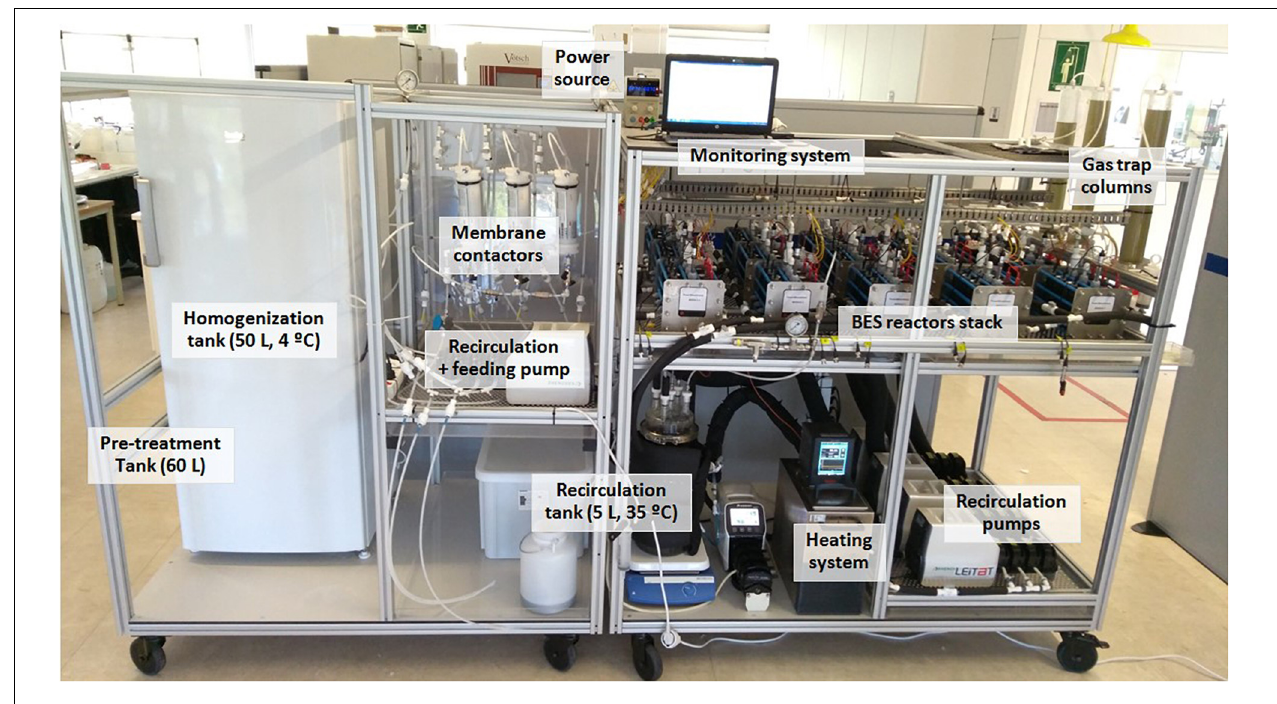
FIGURE 1 | Photo of the prototype. Left side : CO 2 capture system. Right side : EMG-BES stack.